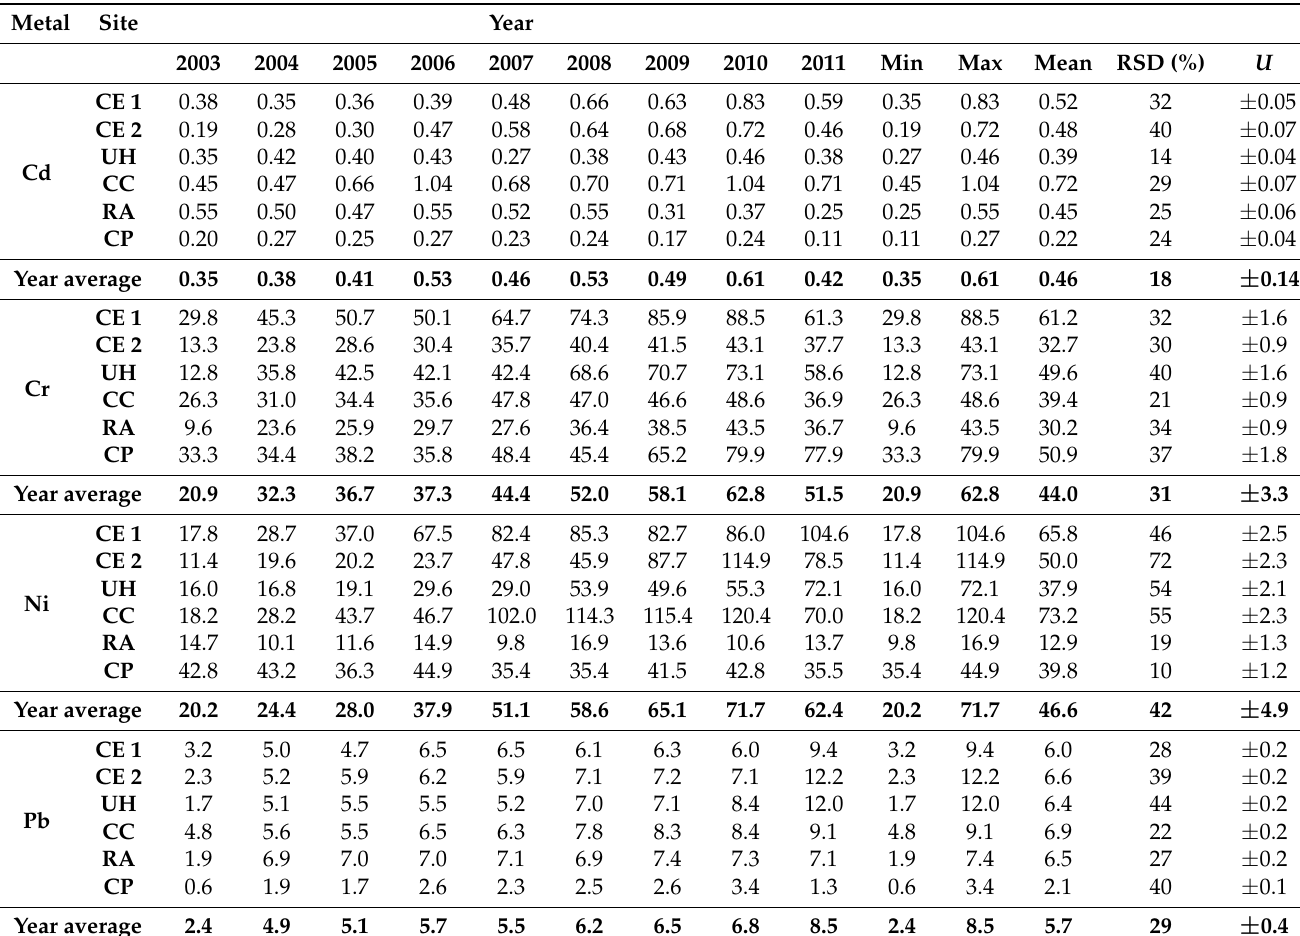
Table 2. Metal content (mg/kg) values for each sampling site and each year, minimum (Min), maximum (Max), mean (Mean) values and relative standard deviation of the mean (RSD %). Expanded uncertainty values ( U ), for 95% confidence level, are shown in the last